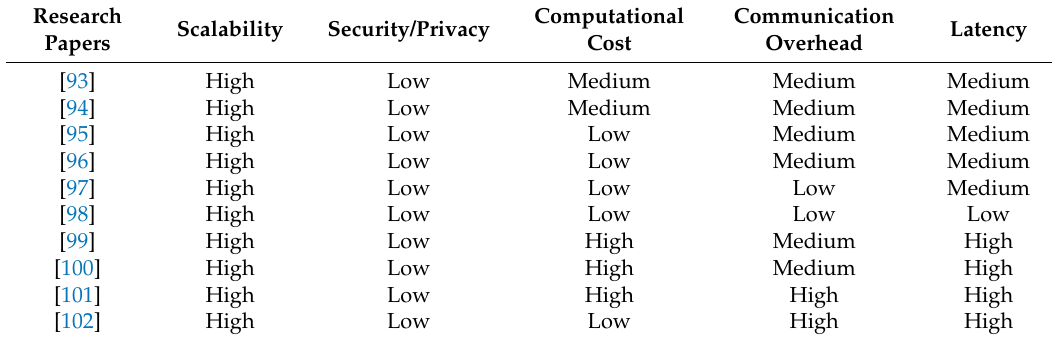
Table 7. Symmetric based encryption schemes performance.